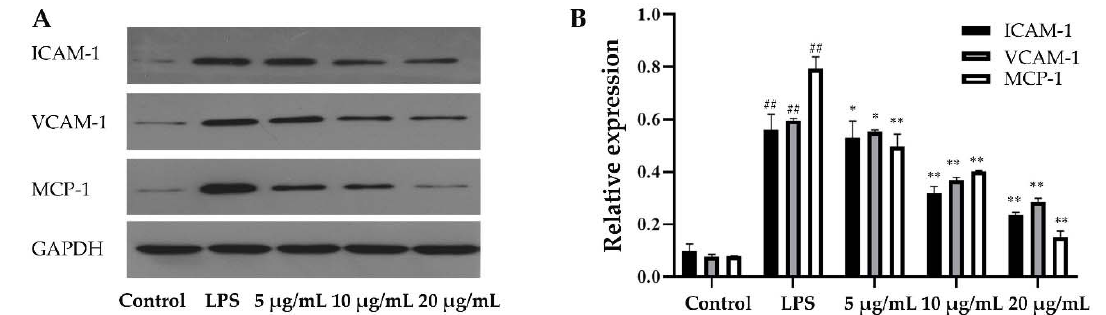
Figure 6. E ff ects of EEP-B on the levels of MCP-1, ICAM-1 and VCAM-1. ( A ). Protein expression Figure 6. Effects of EEP ‐ B on the levels of MCP ‐ 1, ICAM ‐ 1 and VCAM ‐ 1. A. Protein expression of MCP ‐ 1, ICAM ‐ 1 and VCAM ‐ 1. B. Relative expression of MCP ‐ 1, ICAM ‐ 1 and VCAM ‐ 1. ## means